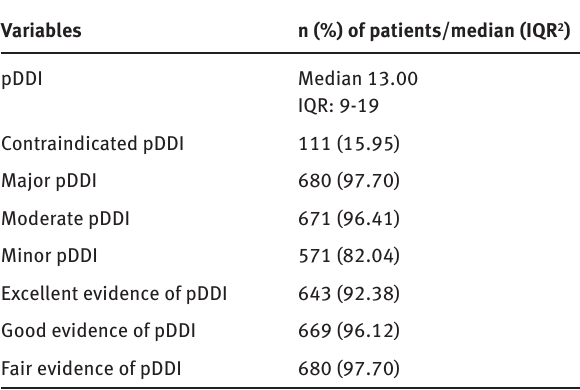
Table 2: Characteristics of potential drug-drug interactions pDDI1 of cohort with acute ischemic